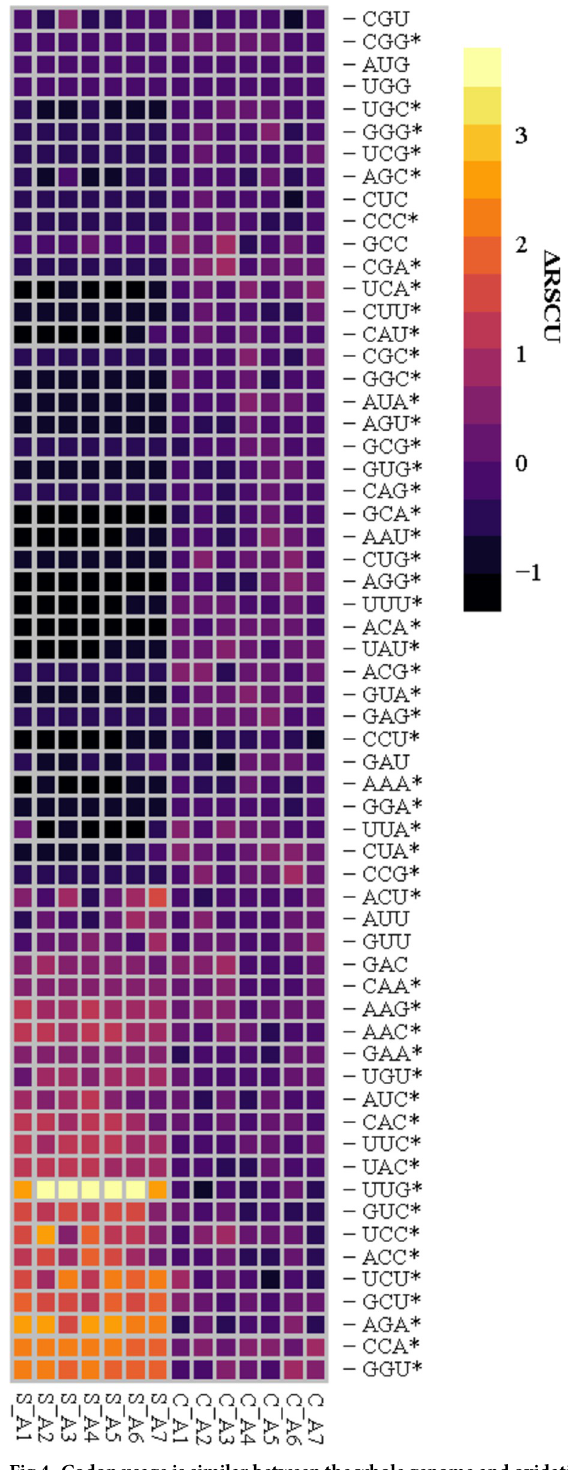
Fig 4. Codon usage is similar between the whole genome and oxidative response transcripts in C . neoformans . The Δ RSCU of seven UUG-rich genes in S . cerevisiae (S_A1 –S_A7) and the seven homologous genes identified in C . neoformans JEC21 (C_A1 –C_A7) ( S7 Table ). Δ RSCU values were calculated by subtracting the gene RSCU from the whole genome RSCU for each codon. Therefore, values equal to 0 indicate the codon is in similar usage as the